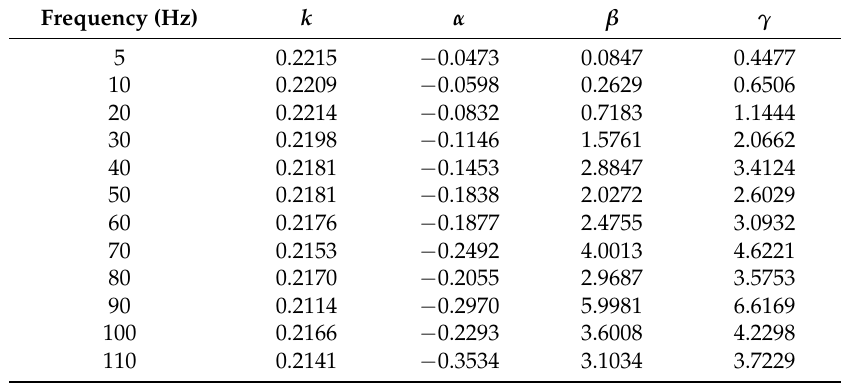
Table 1. Identified parameters of the classical Bouc–Wen (CB–W) model at different frequencies. Frequency